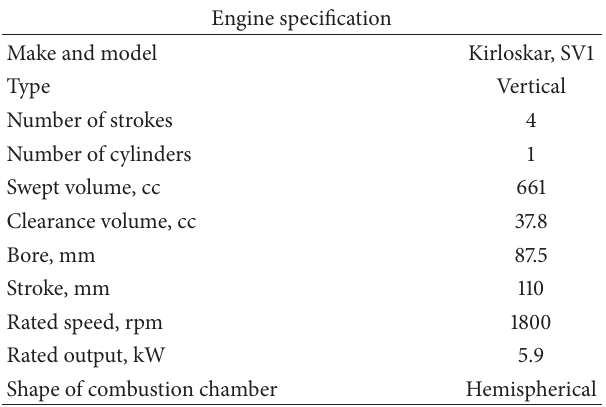
Figure 1: Experimental setup. ADC: analog-to-digital converter; D/W emulsion: diesel-water emulsion. Table 2: Engine